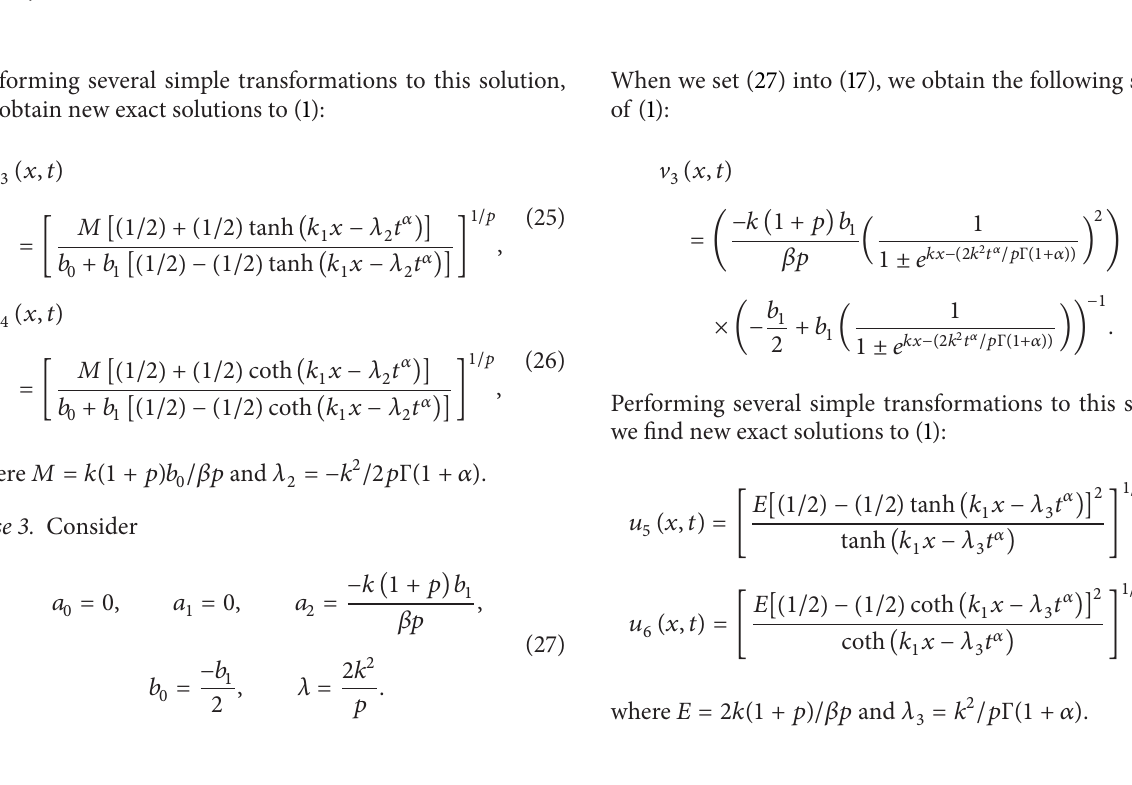
Figure 4: Two-dimensional graph of the solution (25) corresponding to the values 𝛼 = 0.05 , 𝛼 = 0.85 , respectively, when 𝑘 = 1 , 𝑝 = 3 , 𝑏 0 = 3 , = 1 , 𝛽 = 2 , 𝑡 = 1 , and −15 < 𝑥 < 15 𝑏 1